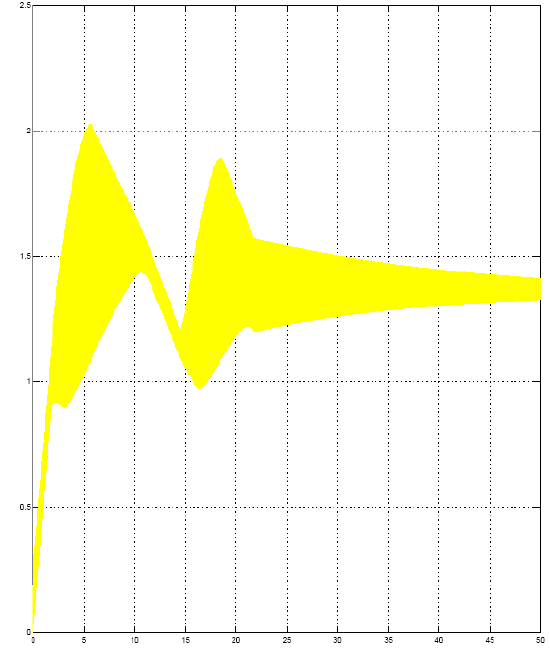
Fig. 3 Pitch Angle (in radians) versus time settles near π/2 radian with error.